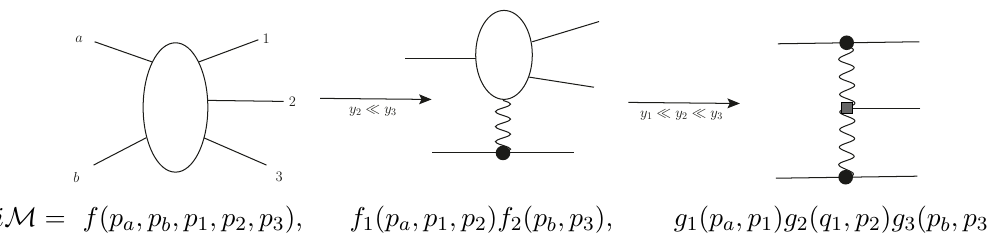
Figure 5. In the limit that particles are well-separated in rapidity, QCD matrix elements factorise into independent pieces dependent only on a subset of momenta, as illustrated. This is true in the full high-energy limit where all particles are well-separated in rapidity (right-hand side), but also when the limit only applies to a subset of particles